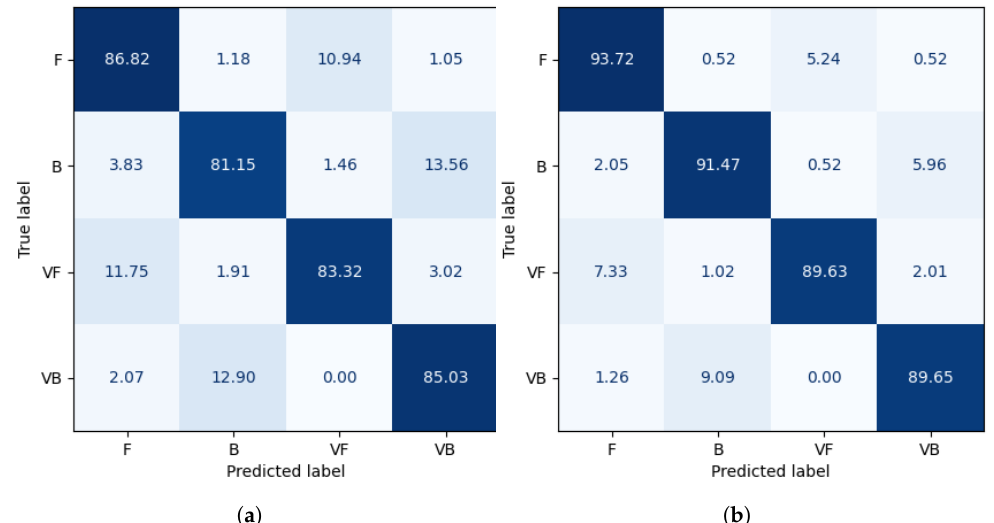
Figure 6. Confusion matrices (in %). ( a ) Matrix for input without the tennis racket. ( b ) Matrix for input with the tennis